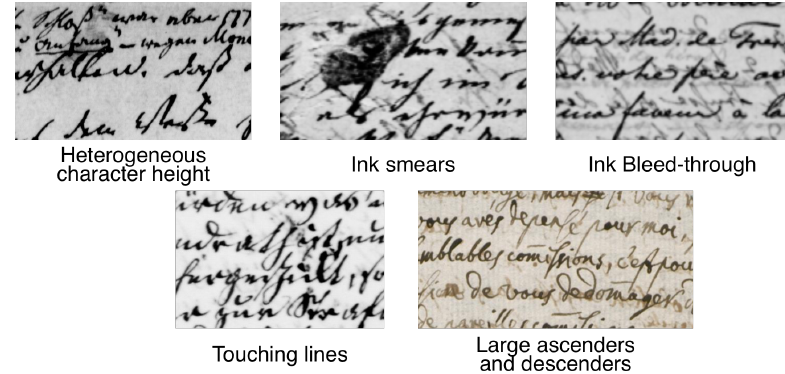
Figure 1. Examples of challenges in a recent historical handwritten text line detection dataset,